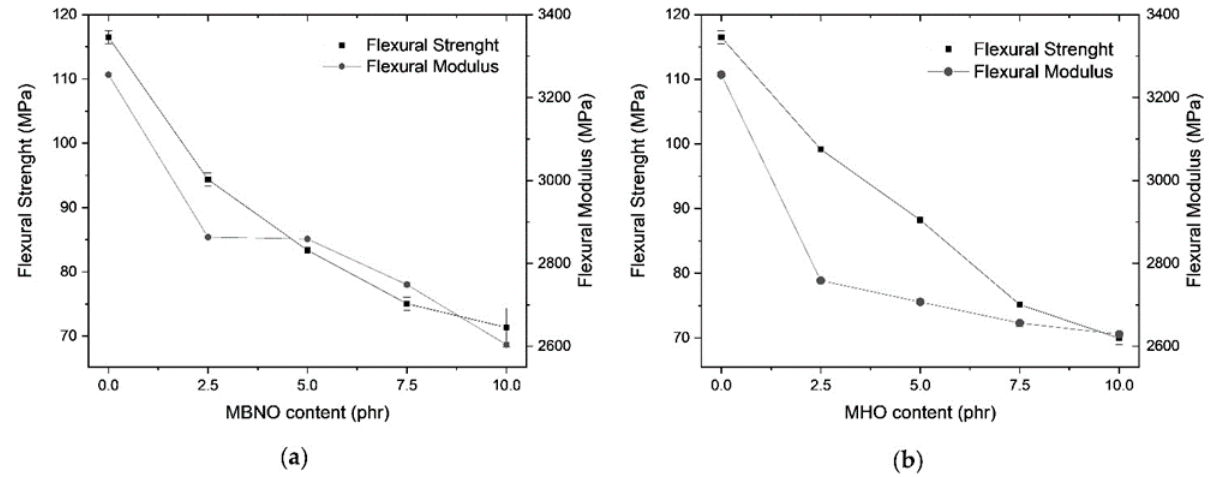
Figure 6. Plot of evolution of flexural properties of PLA formulations plasticized with various contents of MBNO ( a ) and MHO ( b ).